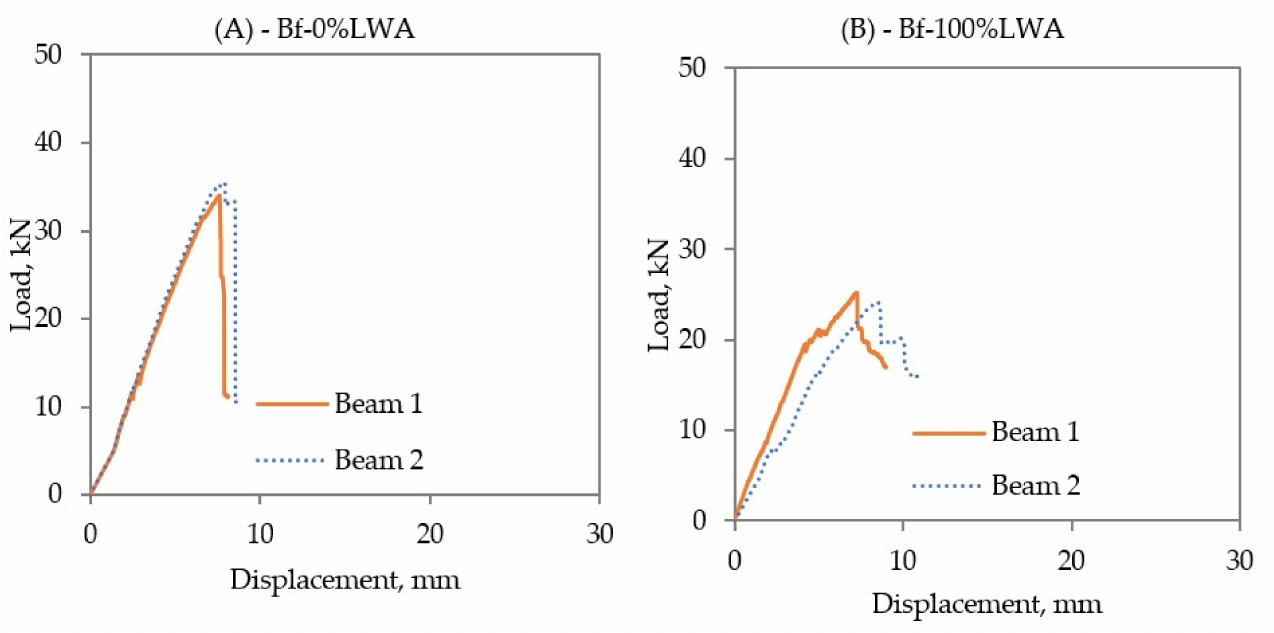
Figure 8. Load–displacement relationship of ( A ) Bf-0%LWA, and ( B ) Bf-100%LWA beams.